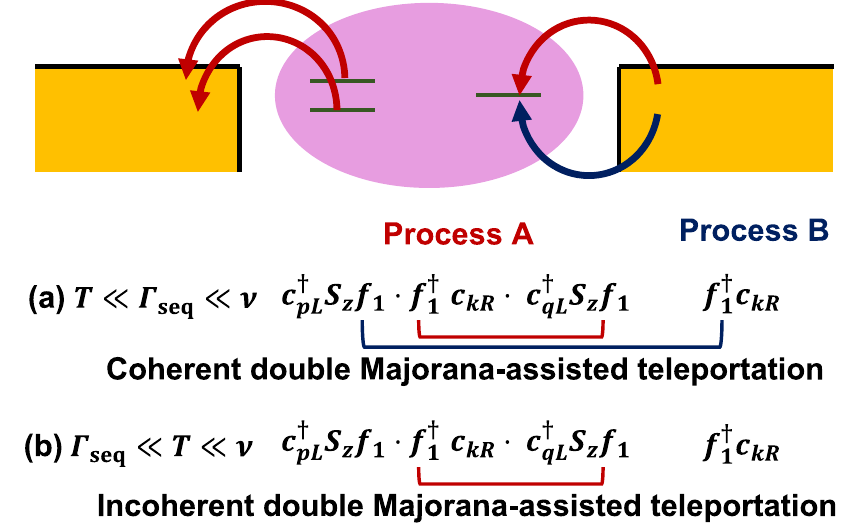
assisted teleportation. b In the regime Γ seq ≪ T ≪ ν , these two processes become